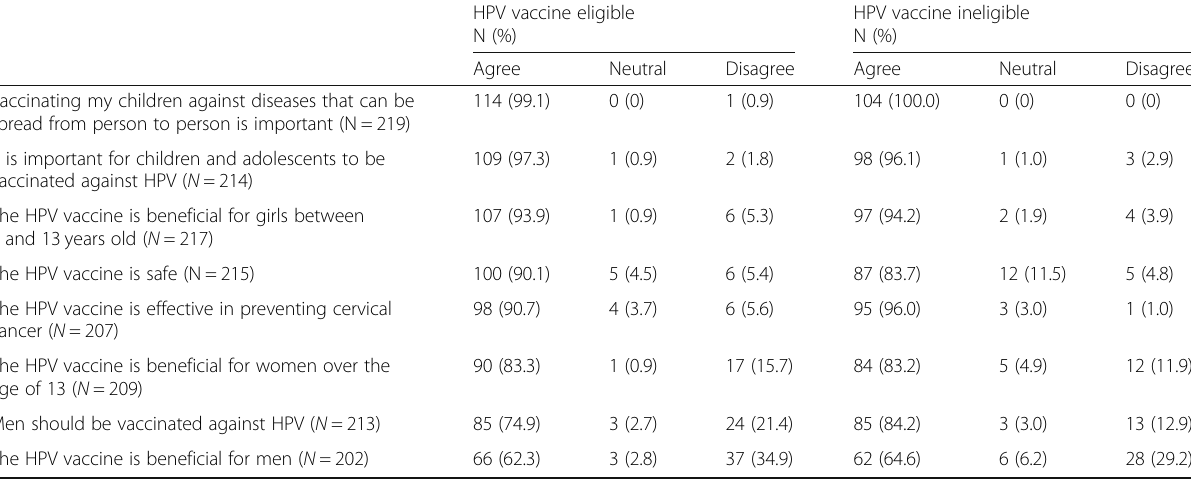
Table 3 Attitudes about vaccination and the HPV vaccine among parents with children between the ages of 9 and 17 in São Paulo, Brazil, 2015